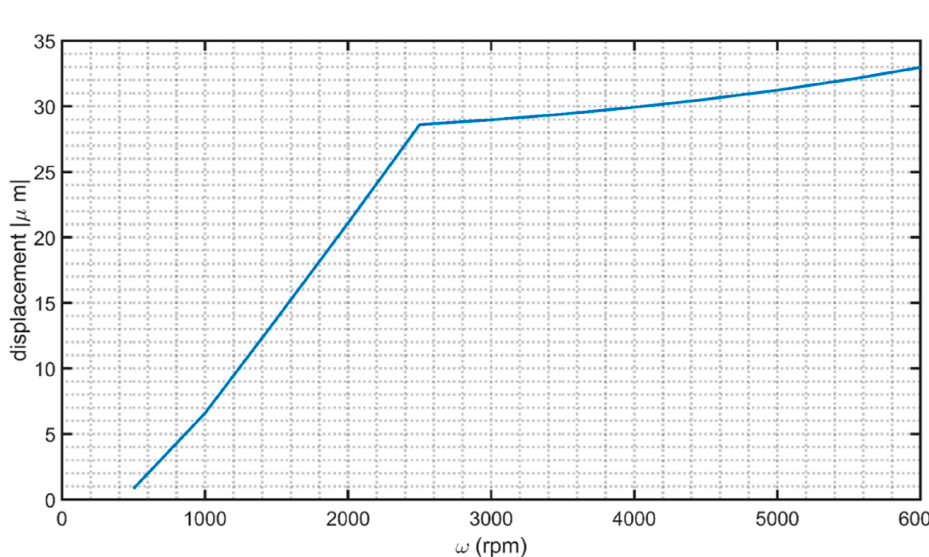
Figure 18. Mode shape: ( a ) 3D view; ( b ) 2D view.